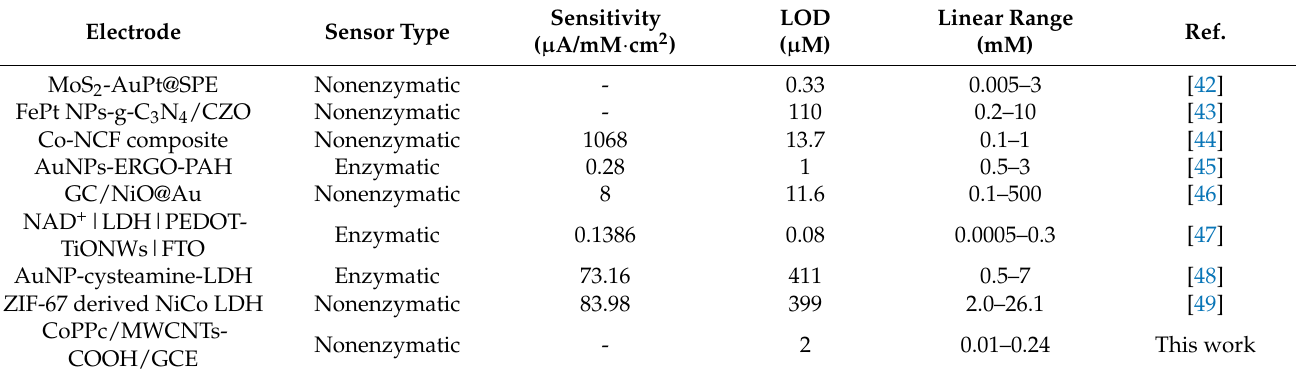
Figure 5. The CoPPc/MWCNTs-COOH/GCE sensor for the determination of different concentrations of lactic acid in 0.1 mol/L PBS (pH 4.0). Table 1. List of recently reported lactic acid sensors with the sensor fabricated in the present